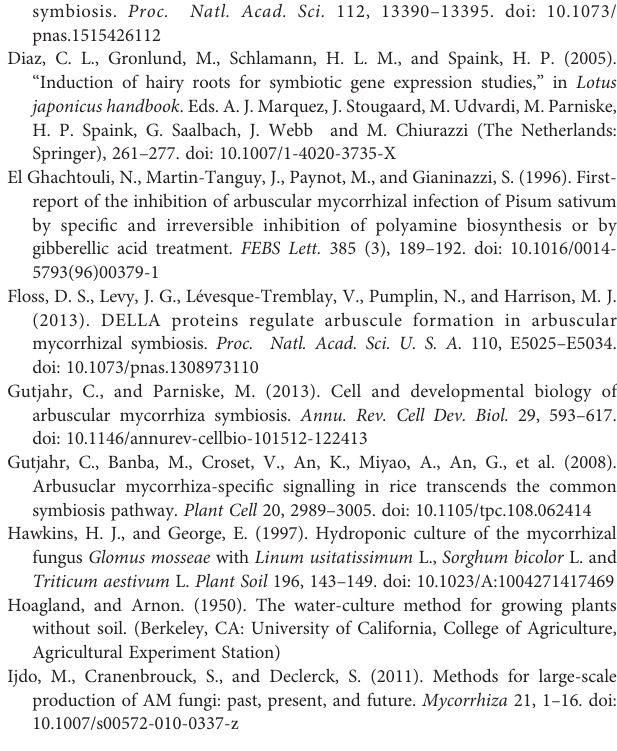
FIGURE S1 | Spatiotemporal AM colonization in tip-wick hydroponics. ( A ) Experimental set-up to examine the effect of distance to the air stone (c, close; f, far) and position in the root (tip or free) on AM colonization in L. japonicus seedlings. ( B ) L. japonicus root length colonization by R. irregularis at 5, 6, and 7 wpi inside the tip or in free- fl oating roots, close (open circles) or far (black circles) from the air stone (statistics:Mann-Whitney test, n= 3separate plantsfromthe threeindependent tip- boxes). ( C ) Free- fl oating root length (left) and number of hyphopodia in free- fl oating rootlength(right)indicatingthatthefunguscanre-colonizetherootfromtheoutside below the rock wool (n = 3 separate plants from three independent tip-boxes). Indications of centimeters on the y-axis refer to root segments below the rock wool. Less than three open or closed circles indicate that not all root systems were long enough to contribute a segment in the indicated category. FIGURE S2 | High phosphate mediated inhibition of root colonization in tip-wick hydroponics. Effect of 2.5 m M and 2500 m M phosphate on percent root length colonization in L. japonicus by R. irregularis at 6 wpi (statistical analysis: Mann- Whitney test, n = 9 separate plants from one tip-box). FIGURE S3 | Rice growth in co-culture with R. irregularis in Falcon-wick hydroponics. ( A ) Rice plants grown in non-aerated (left) or aerated (right) hydroponics. ( B ) Root and shoot fresh weights for rice plants grown in non-aerated and aerated hydroponics (statistics: Mann-Whitney test, n = 5 separate plants from one